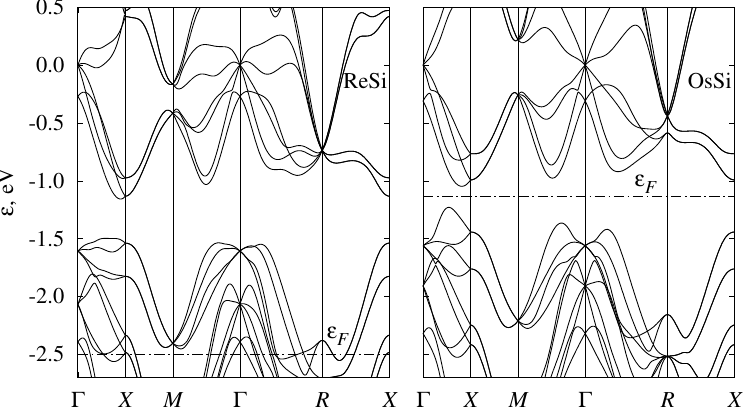
Figure 4. Band structure of ReSi and OsSi with B20 (P2 1 3, #198) crystal structure. Energy measured relative to fourfold band crossing at Γ point. Dash-dotted line shows Fermi